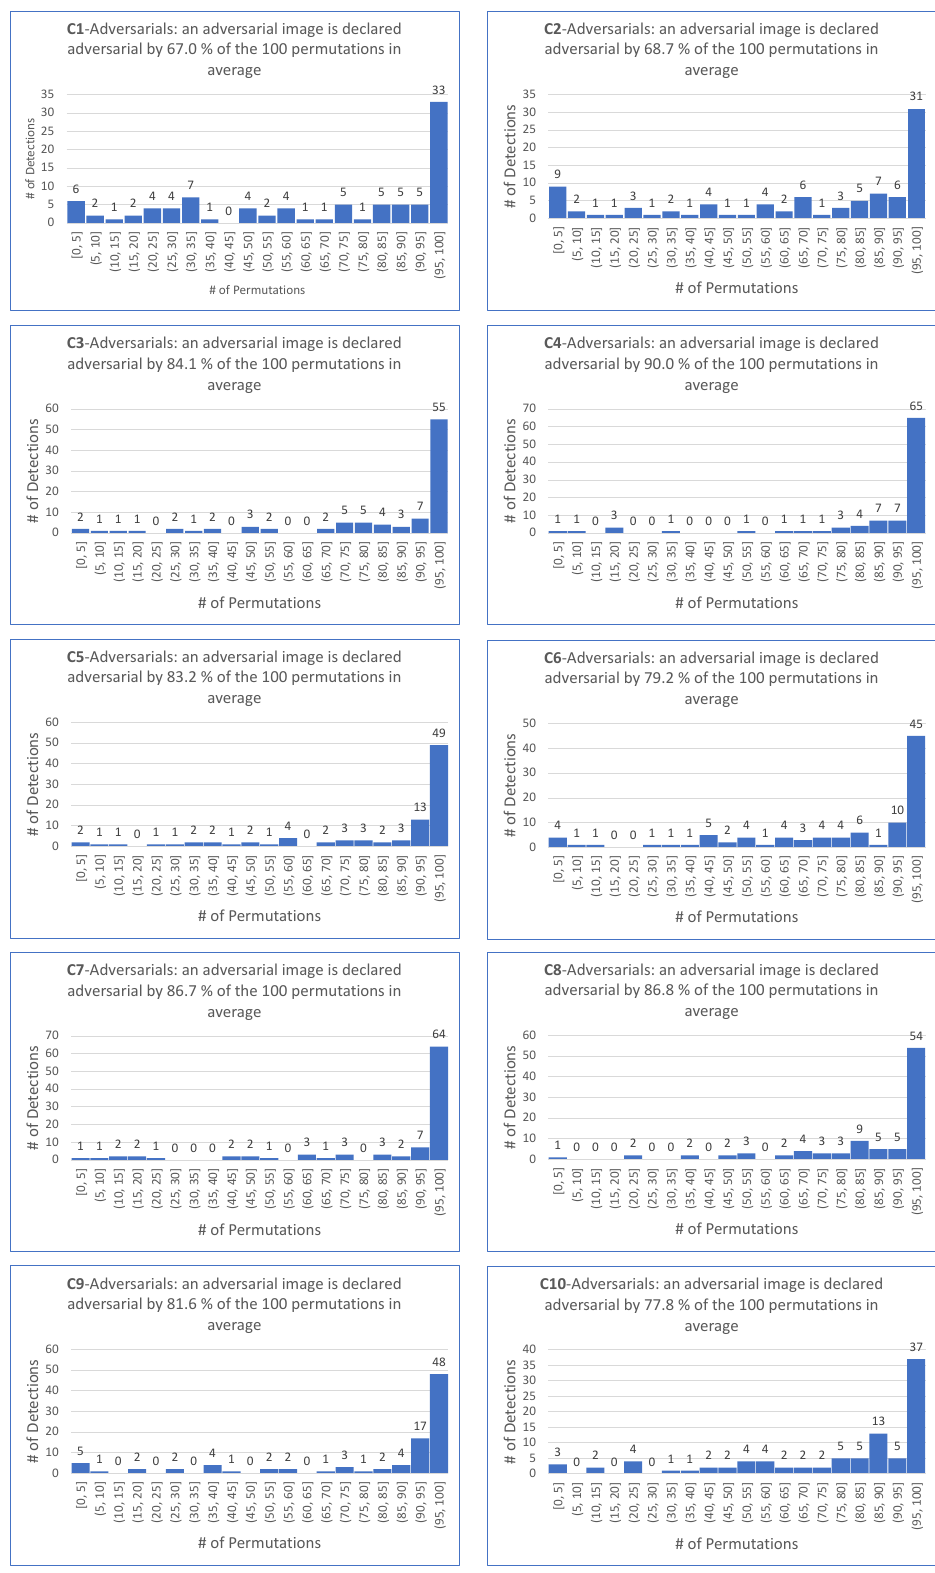
Figure A9. ShuffleDetect results for adversarial images generated by the BIM-untargeted attack on C = C for 1 ≤ k ≤ 10 over 100